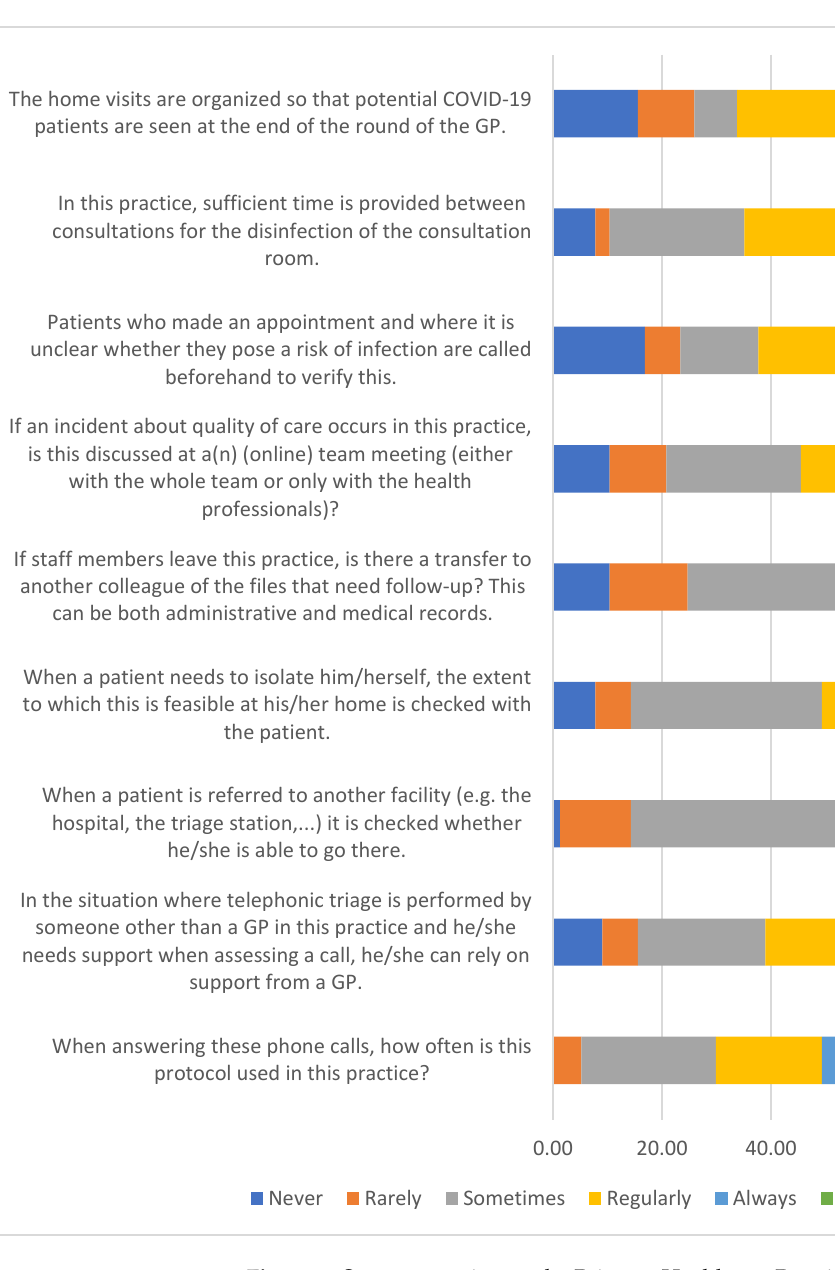
Figure 2. Support services at the Primary Healthcare Practices to improve patient safety during the COVID-19 pandemic.